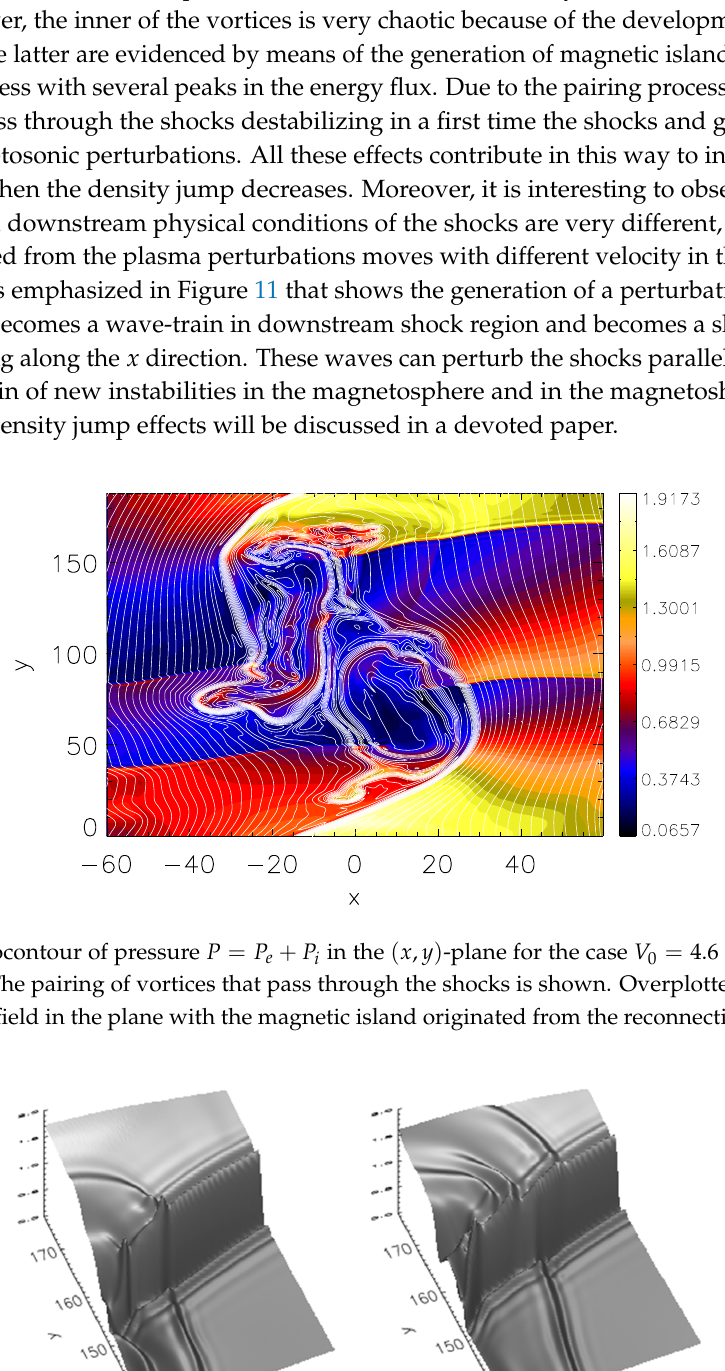
Figure 11. Pressure perturbation P T in the ( x , y ) -plane for the case V 0 = 4.6 and ∆ n = 0.7 at t = 360 (left panel) and at t = 365 (rigth panel). Due to the different conditions upstream and downstream the shocks, the perturbations originated at the edge of vortex propagate in the x -direction with different velocities in the two regions of the shock.